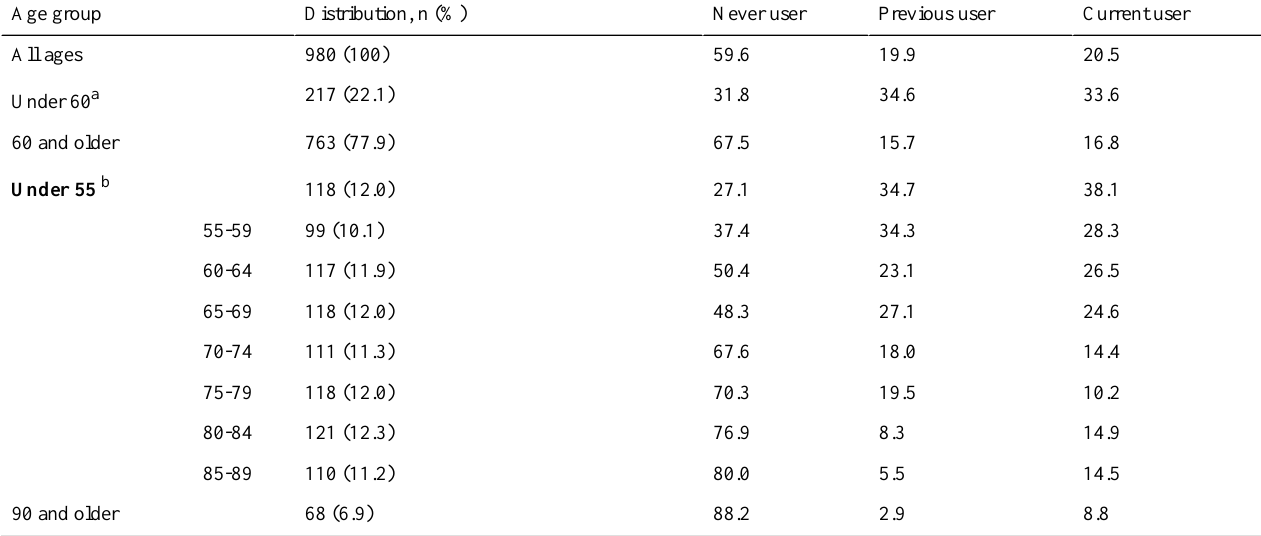
Table 2. Internet use status by age group